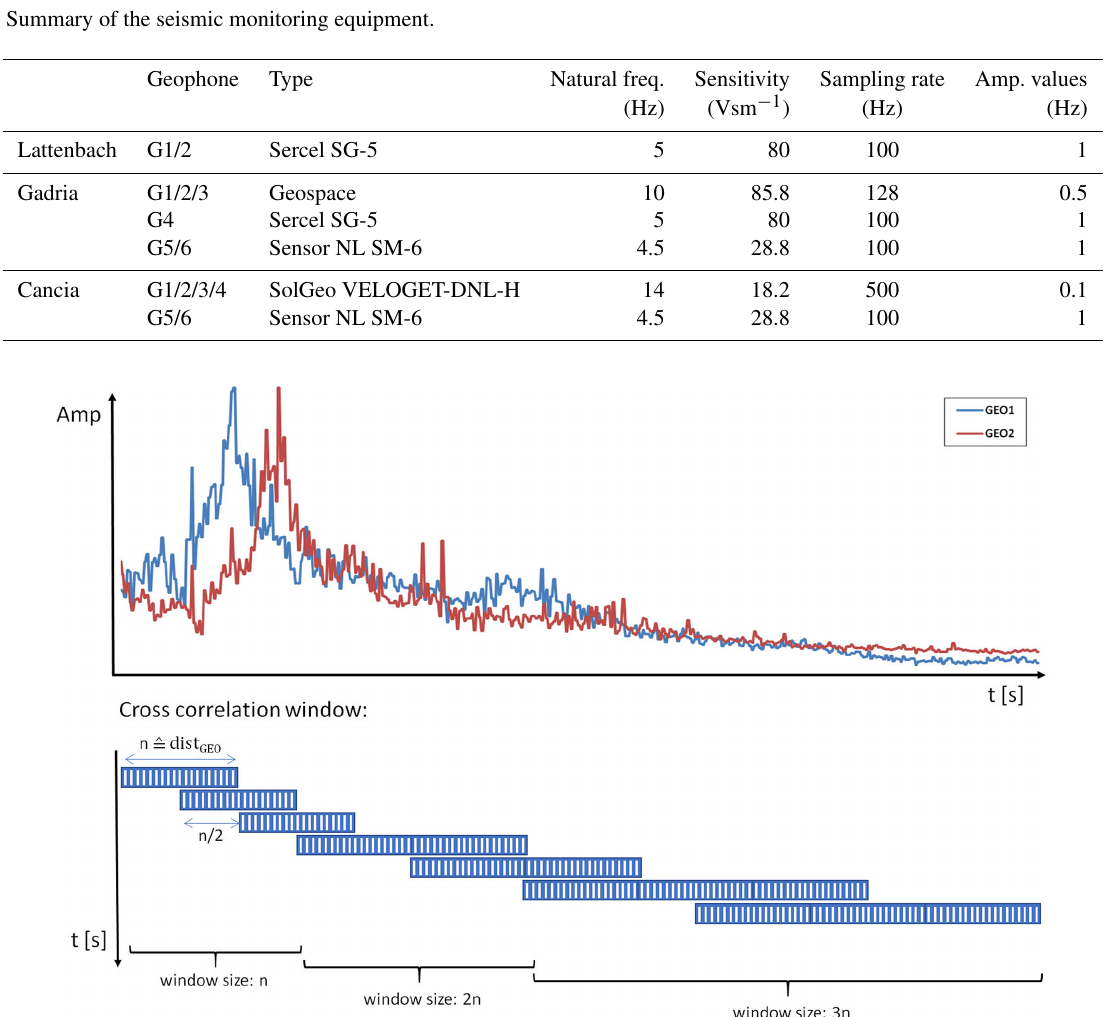
Figure 2. Method cross-correlation analysis: window sizes and